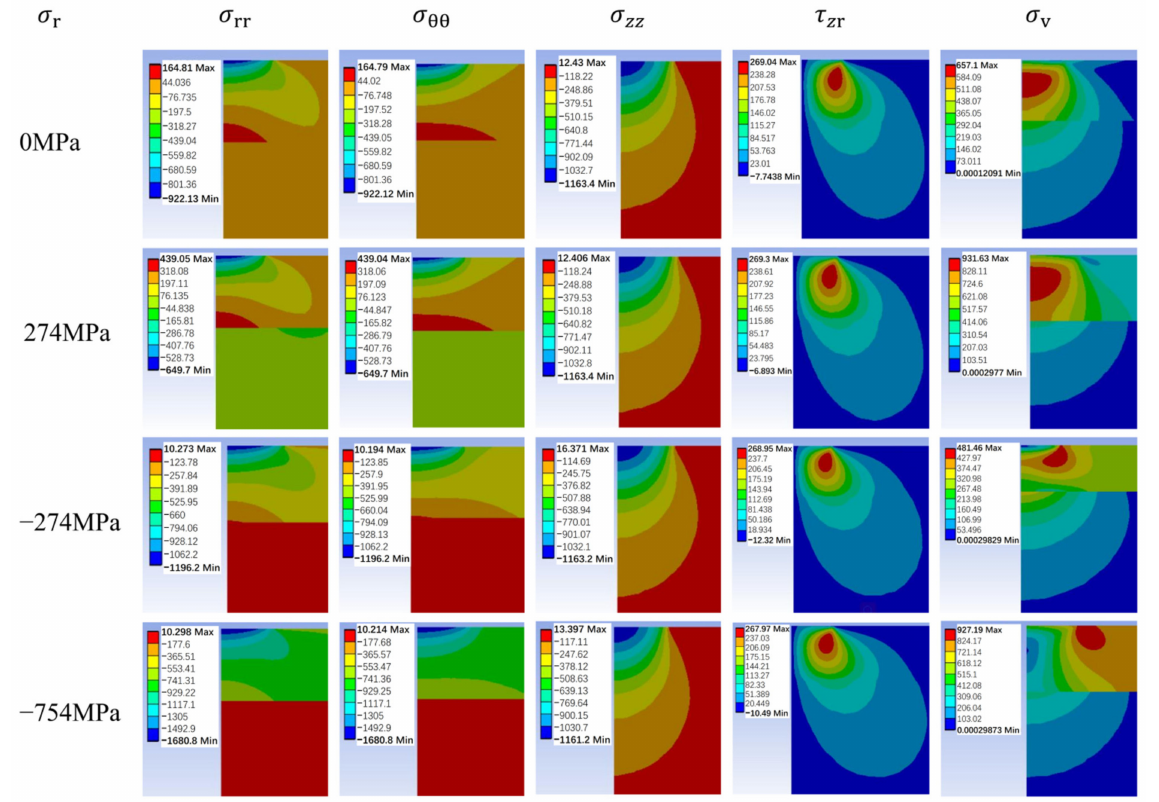
Figure 9. Contact stress field in surface layer without residual stress, with tensile, compressive, and excessive compressive residual stress. The parameters are E s = 200 GPa, E l = 400 GPa, Y s = 600 MPa, Y l = 952 MPa, t / R = 0.006, and P = 0.05